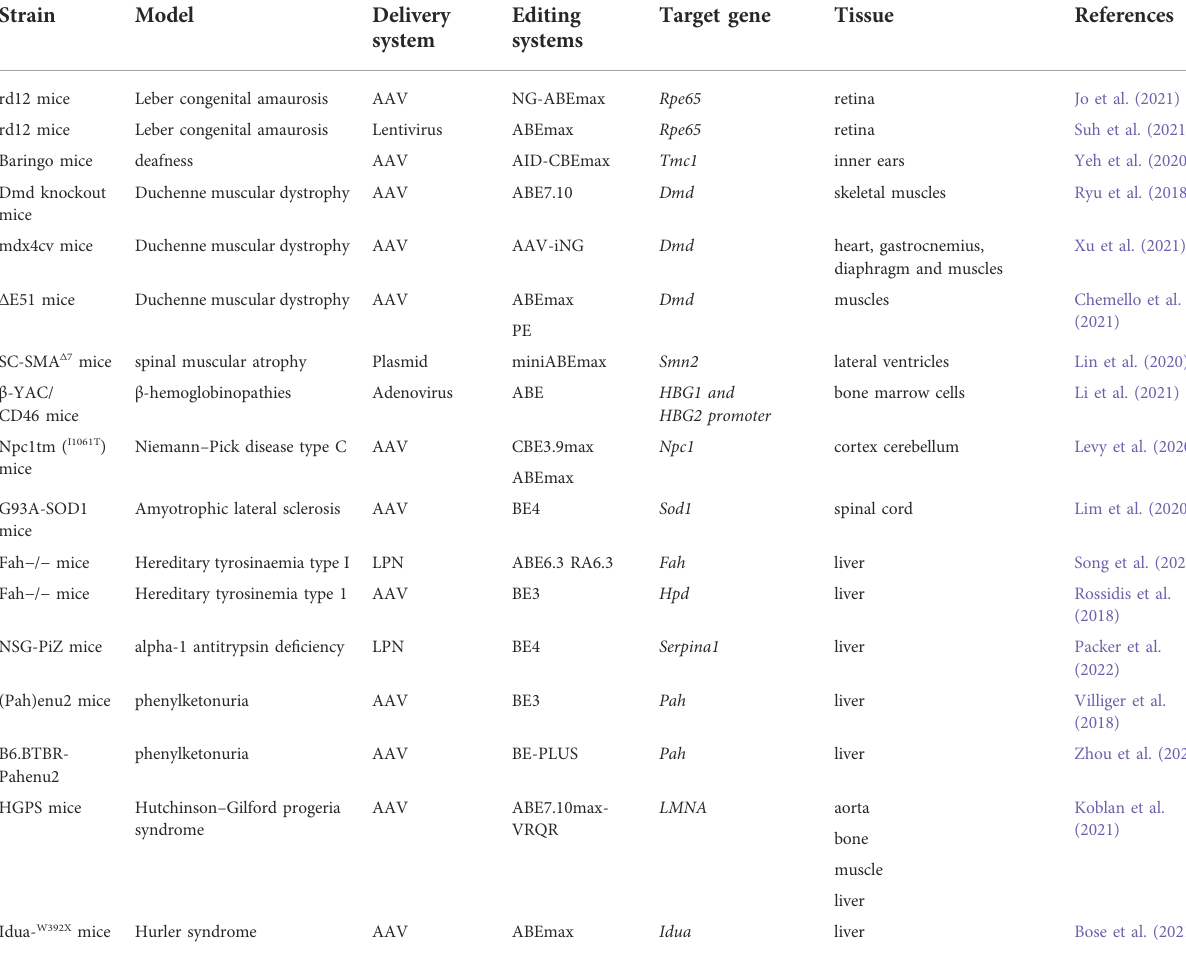
TABLE 1 In vivo DNA editing for therapy of monogenic